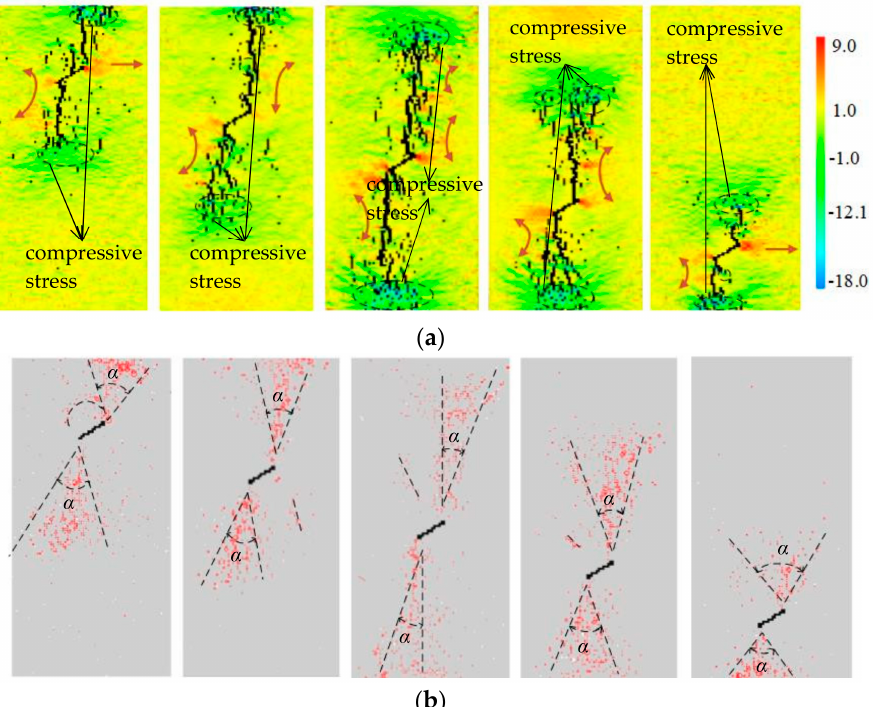
Figure 8. Stress and crack morphology evolution laws at failure stage with ( a ) stress evolution with different joint locations and ( b ) crack microscopic evolution with different joint locations.